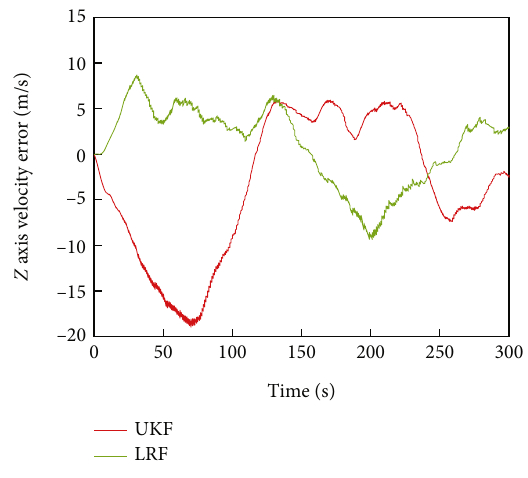
Figure 23: Z -axis velocity error contrast curves Table 4: Root mean square of navigation parameter estimation